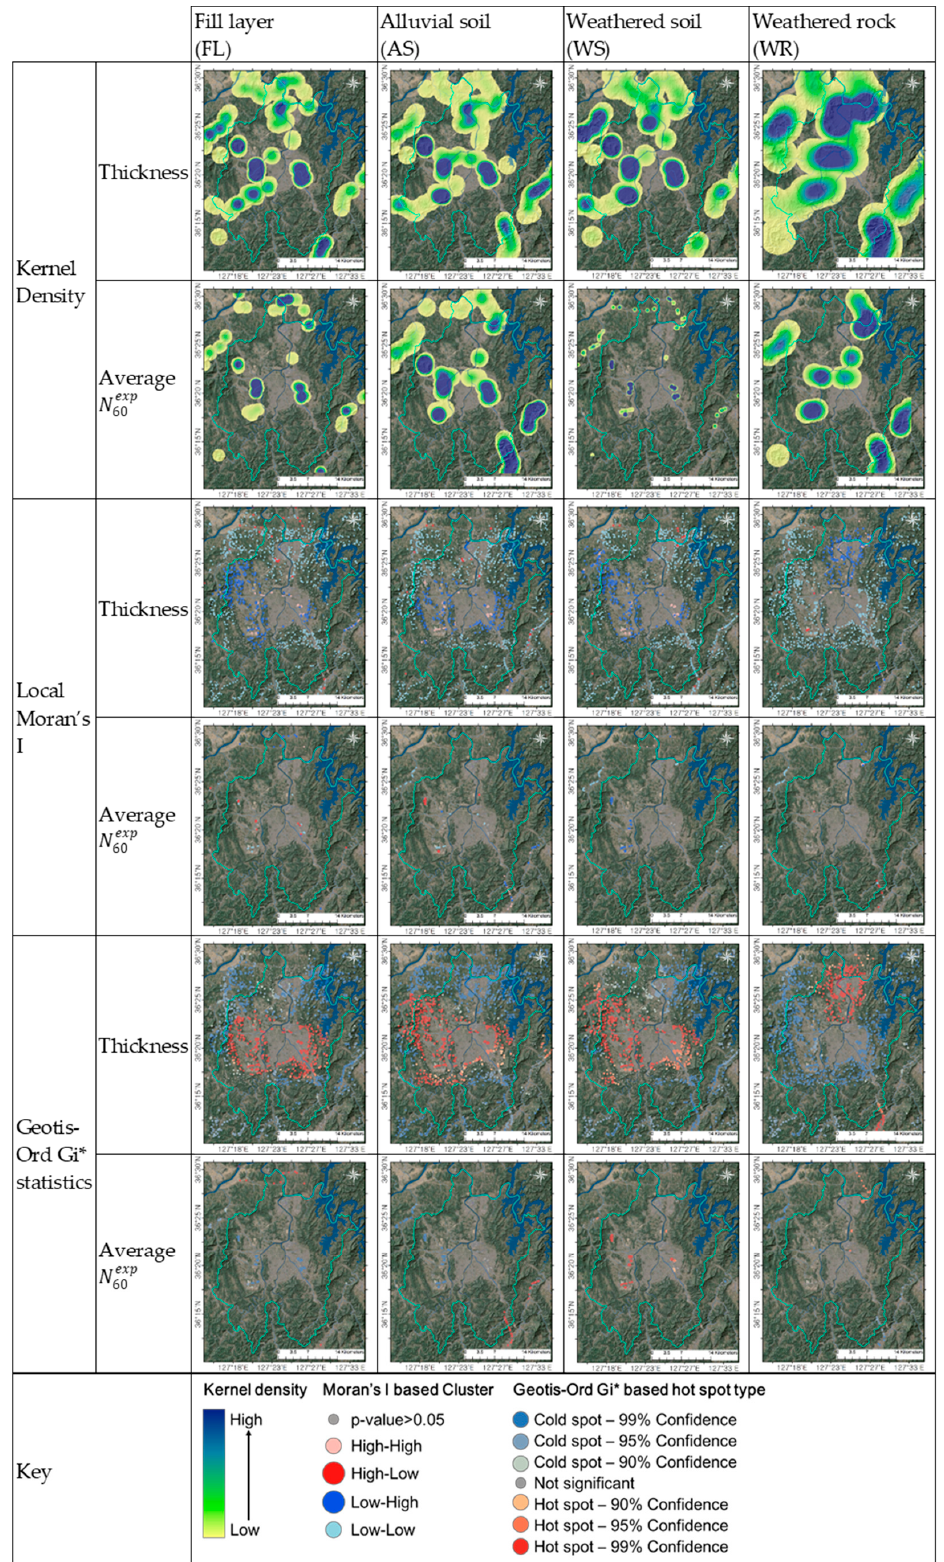
Figure 5. Comparison of three hot spot analysis algorithms (Kernel Density, Local Moran’s I, and Getis-Ord Gi* statistics) applied to the engineering geo-layer thickness and average N exp weathered soil; weathered